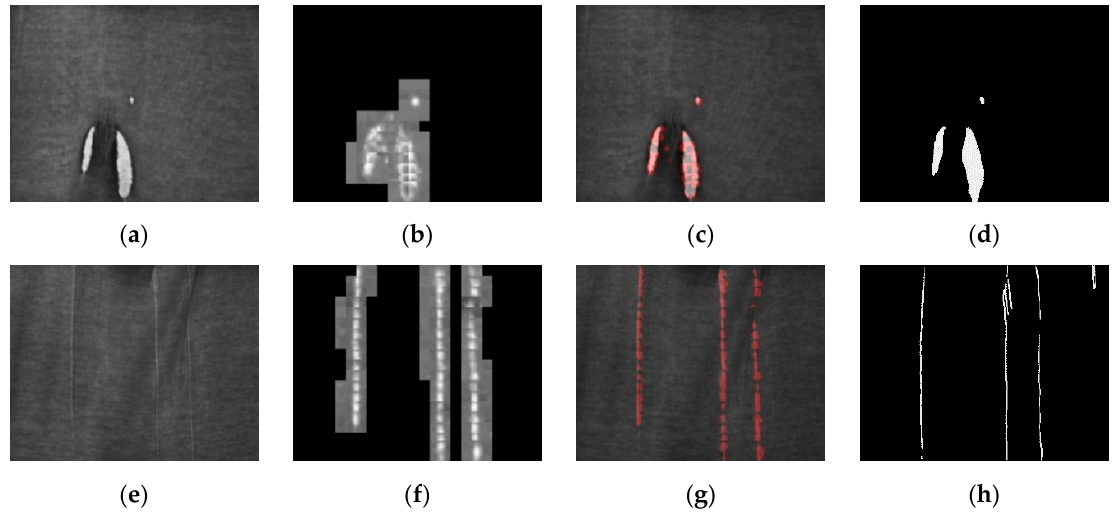
Figure 6. Knitting dataset network prediction result: ( a , e ) original image; ( b , f ) prediction result by segmenting the map with the sliding window; ( c , g ) network prediction confidence map, which is obtained by segmenting Figure ( b ) and ( f ) through a binary process; the red pixels are the defect areas determined on the network; ( d , h ) defect annotation map.